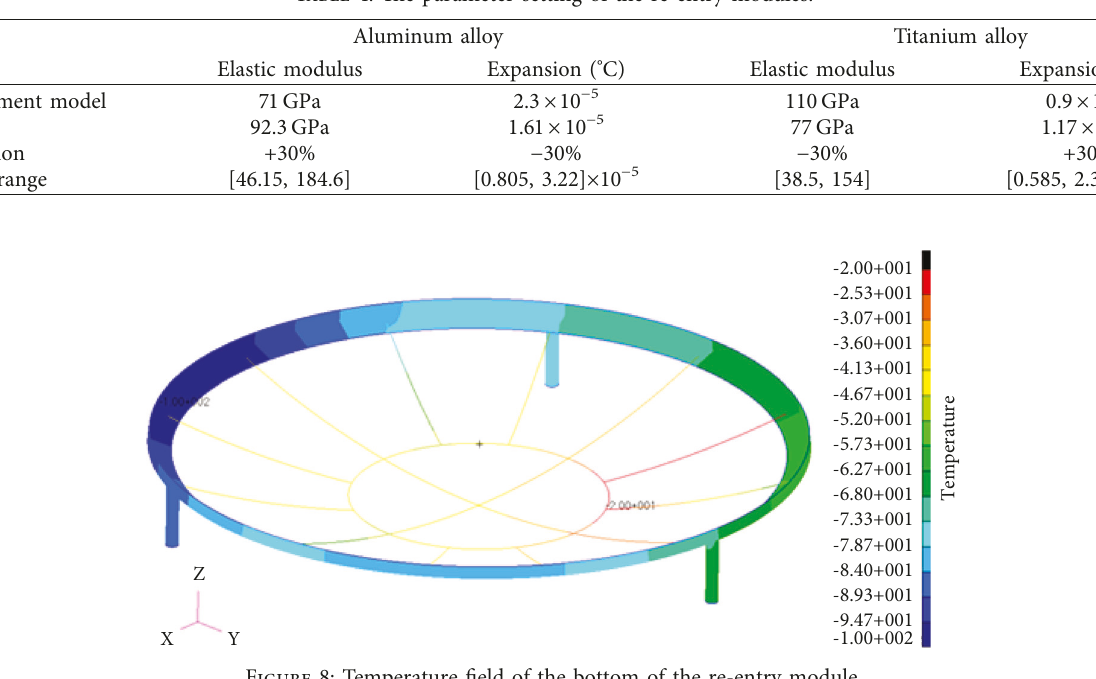
Figure 7: The structure of the bottom of the re-entry module. Table 4: The parameter setting of the re-entry modules.